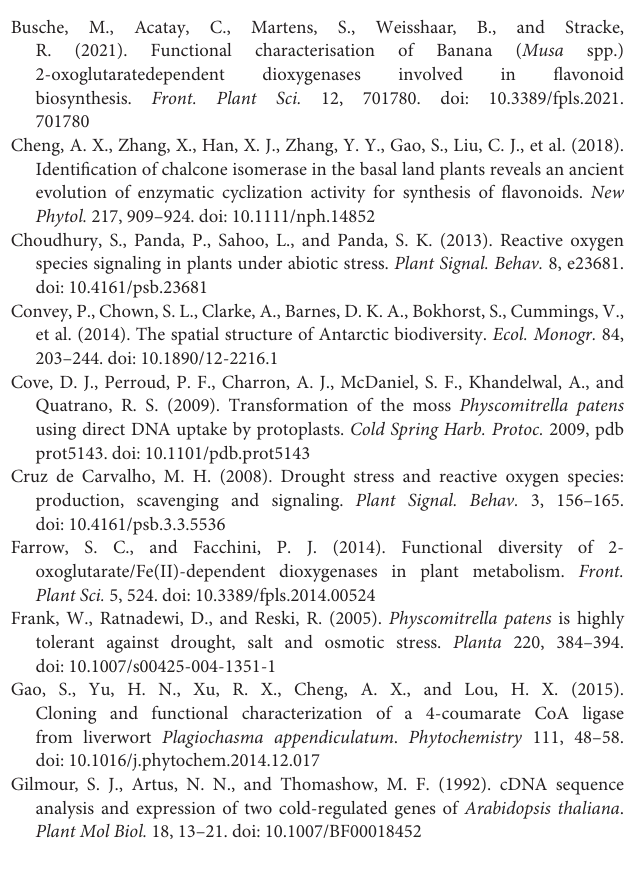
Supplementary Figure 1 | Gene transformation process of Physcomitrella patens and Arabidopsis . (A) Undigested P. patens protonema. (B, C) Digested P. patens protoplasts. (D, E) Screening of transgenic Pn2-ODD1 P. patens and Arabidopsis by antibiotic. (F, G) Identification of Pn2-ODD1 in P. patens and Arabidopsis by PCR analysis. Supplementary Table 1 | All primers used for vector construction and gene expression analysis. Supplementary Table 2 | Differential metabolites (36 up-regulate and 12 down-regulate) identified by the flavonoids metabolomics in 5-day-old WT and transgenic Arabidopsis